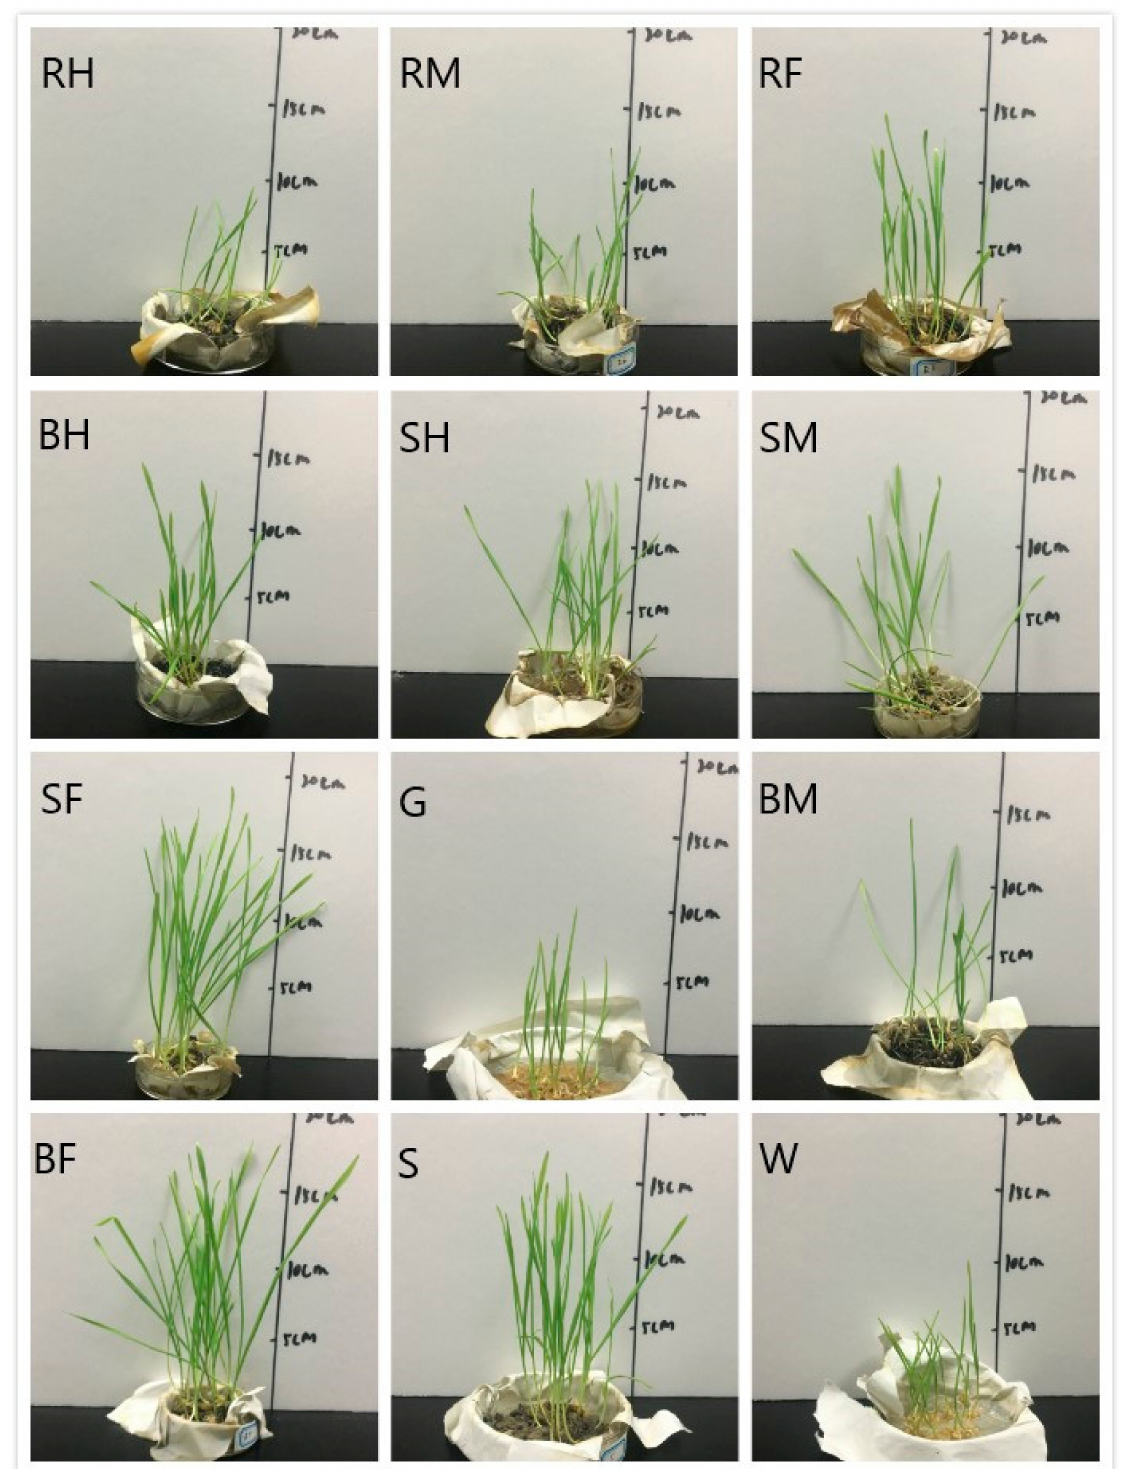
Figure 11. The growth status of wheats at the end of